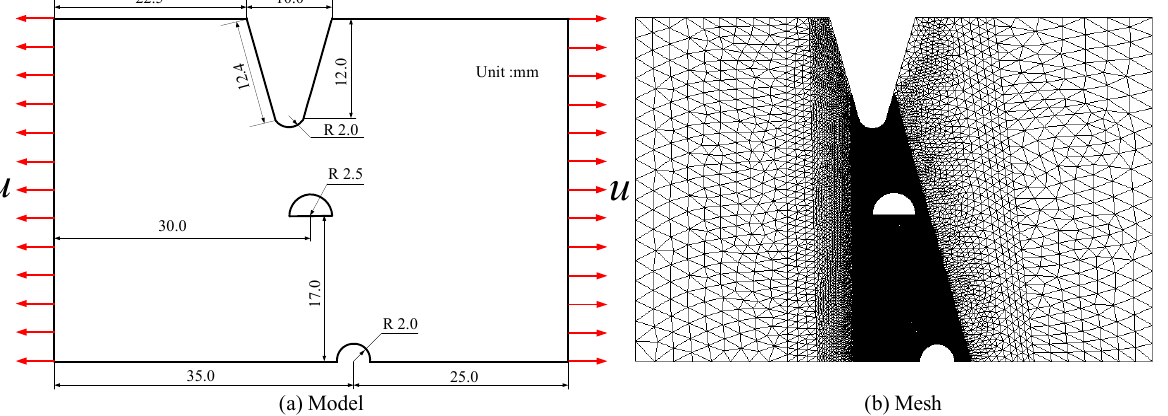
Figure 15. Model and mesh in Case 3.